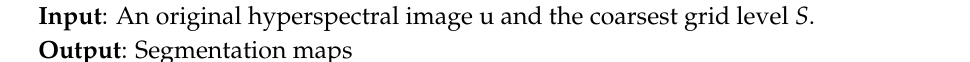
Algorithm 1: AMG-derived M-HSEG Segmentation